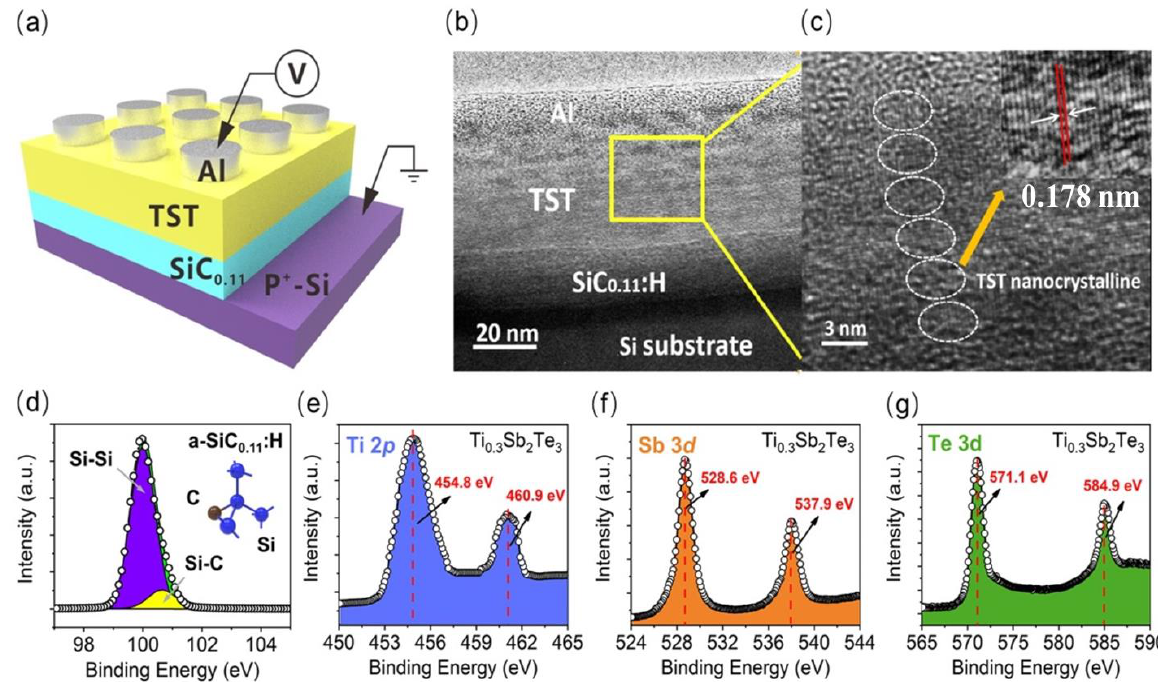
Figure 1. ( a ) The schematic diagram of the Al/TST/a-SiC 0.11 :H/P + -Si memory device after the DC sweeping electrical measurement; ( b ) Cross-section TEM of Al/TST/a-SiC 0.11 :H/P + -Si RRAM device after the first setting process; ( c ) High-resolution cross-section TEM of TST nanocrystalline formed in the Al/TST/a-SiC 0.11 :H/P + -Si RRAM device after electric measurement; The TST nanocrystalline dot is marked by the circles. And the inset shows the interplanar spacing of TST nanocrystalline is 0.178 nm, which is marked by the distance of two red lines. ( d – g ) XPS spectra of a-SiC 0.11 :H and Ti 2 p , Sb 3 d , Te 3 d in Ti 0.3 Sb 2 Te 3 .